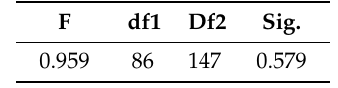
Table 3. Levene’s test of equality of error variances.